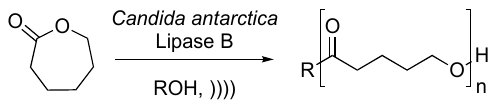
Scheme 27. Synthesis of poly-6-hydroxyhexanoate under enzymatic catalysis. The ultrasonic bath used f = 45 kHz and P input = 120 W. Adapted from Gumel et al. [129].